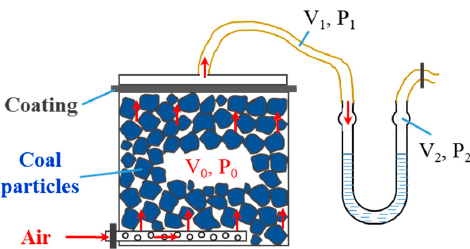
Figure 3. Schematic diagram of three sections of air tightness detection device related to calculation of permeability coefficient of coating.